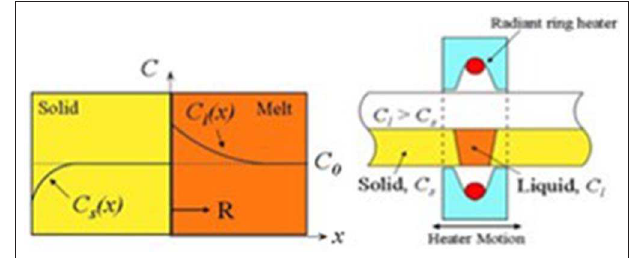
FIGURE 1 | Sketch of the zone refining process.